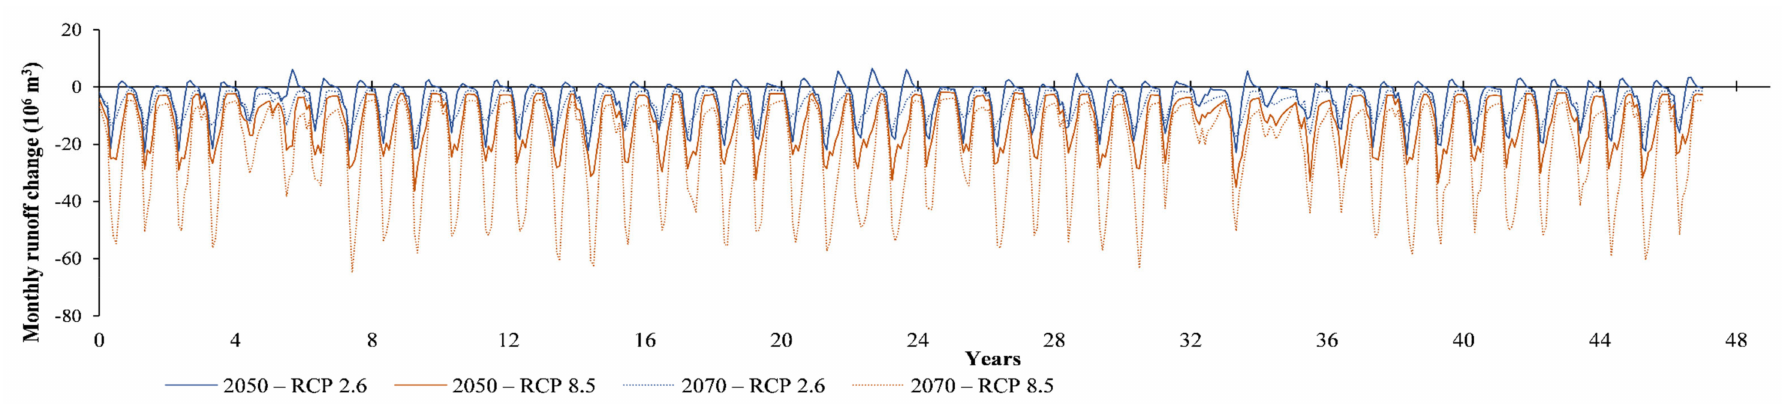
Figure 4. Monthly runoff change (10 6 m 3 ) of future projections based on IPCC climate change scenario RCP 2.6 and 8.5 to the near future (2050) and the far future (2070) using GFDL-CM3 in relation to the historic simulated runoff